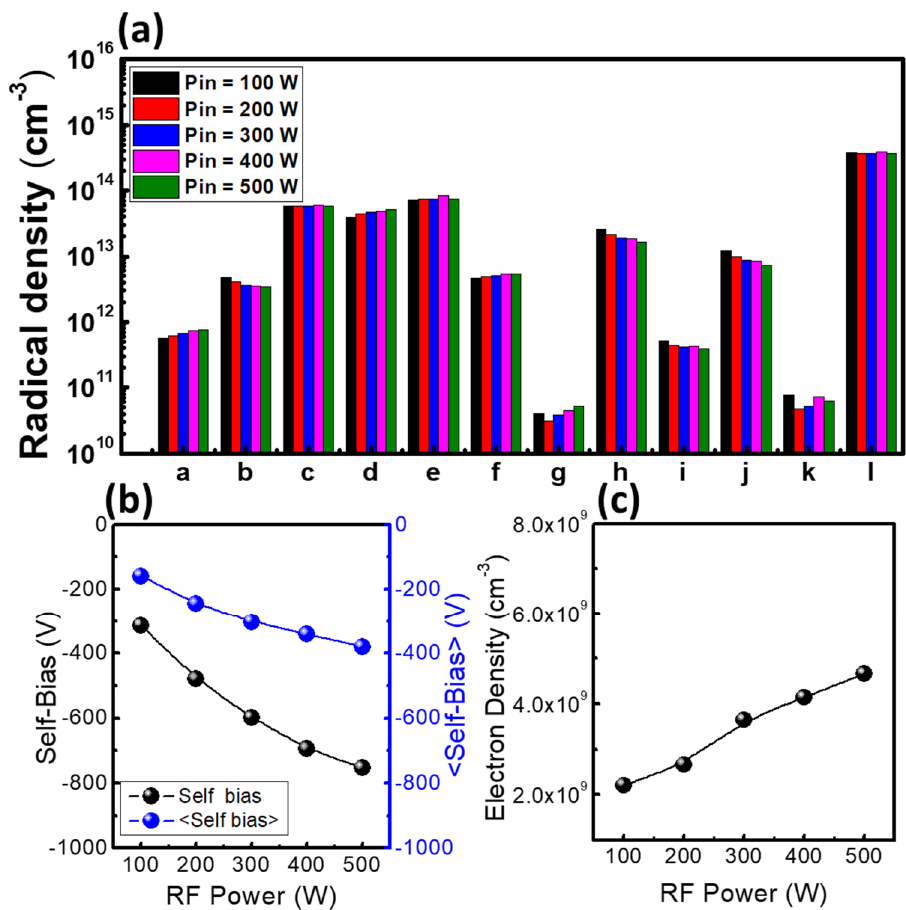
Figure 4. Diagnostic data as a function of input power: ( a ) radical densities, ( b ) self-bias and averaged self-bias, and ( c ) electron density. The parameters for these experiments were a CW RF power, a pressure of 20 mTorr, and a C 4 F 8 /Ar gas ratio of 1:1.